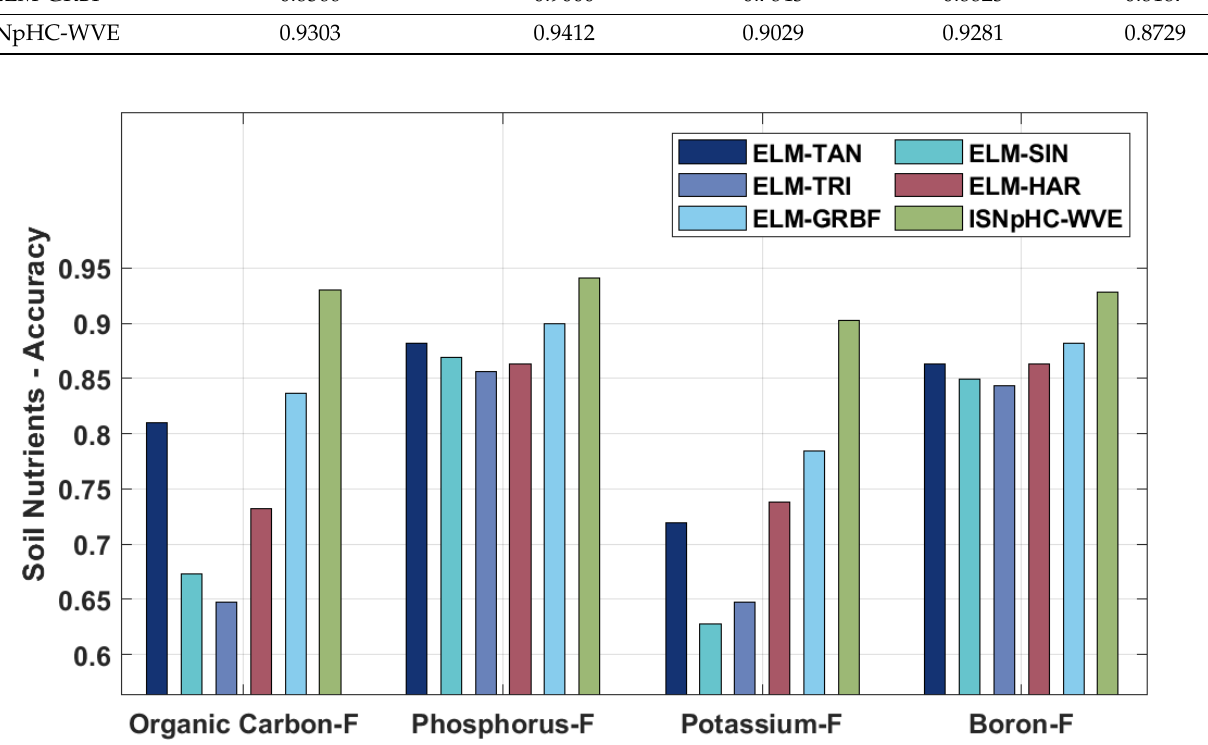
Figure 6. Comparative results analysis of ISNpHC-WVE technique with recent models [10] on soil nutrient classification.